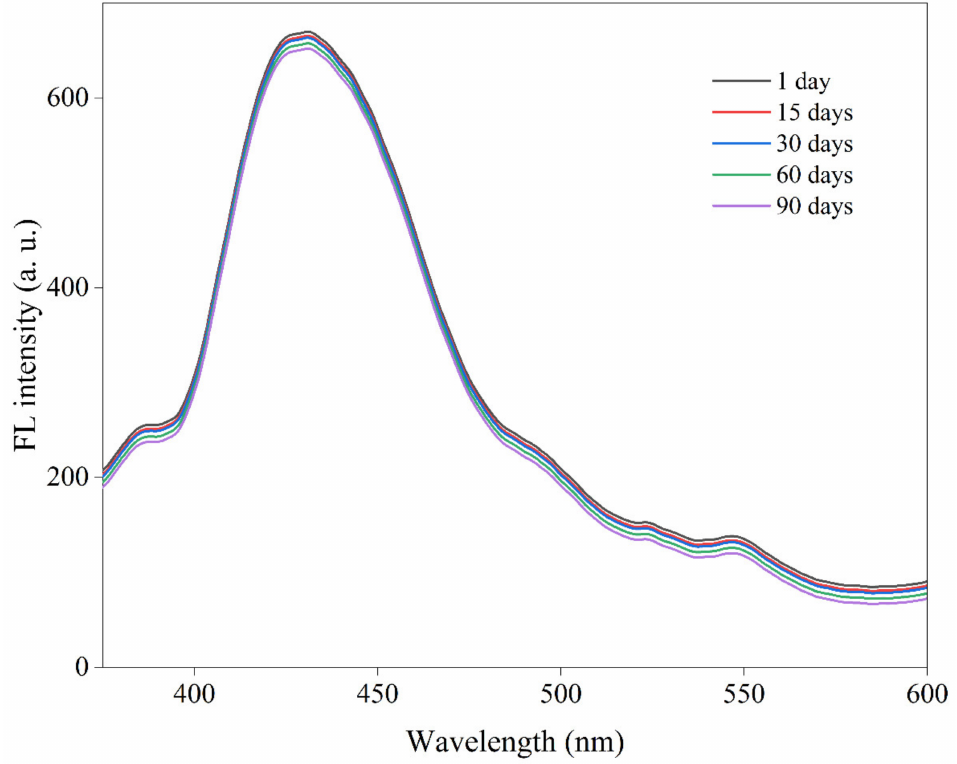
Figure 8. Fluorescence stability of Tb@NH 2 -MIL-253 (Al) MOF sensing platform for 90 days at room